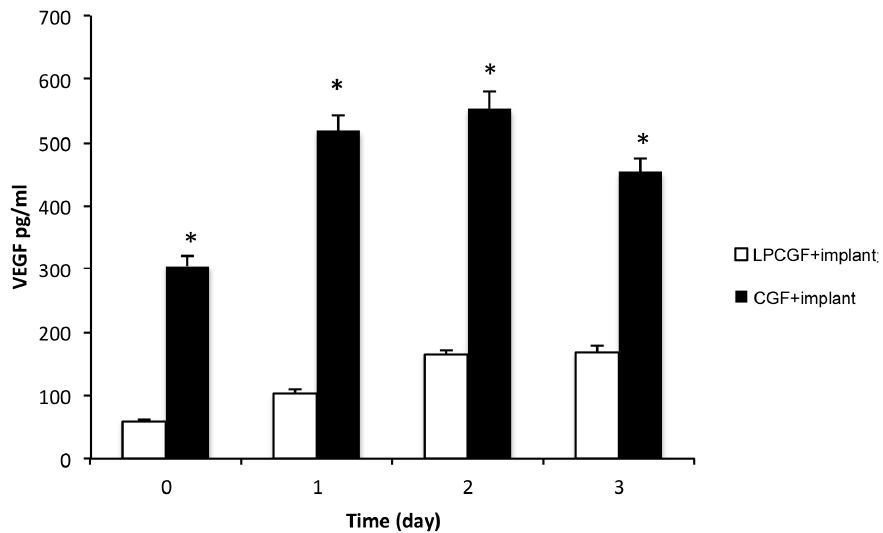
Figure 5. ELISA quantification of human VEGF into PBS from CGF- and LPCGF-permeated implants at various times (0–3 days). Values are means ± SD, n = 3. * p < 0.05 denotes statistically significant differences between the VEGF released by CGF- and LPCGF-permeated implants.